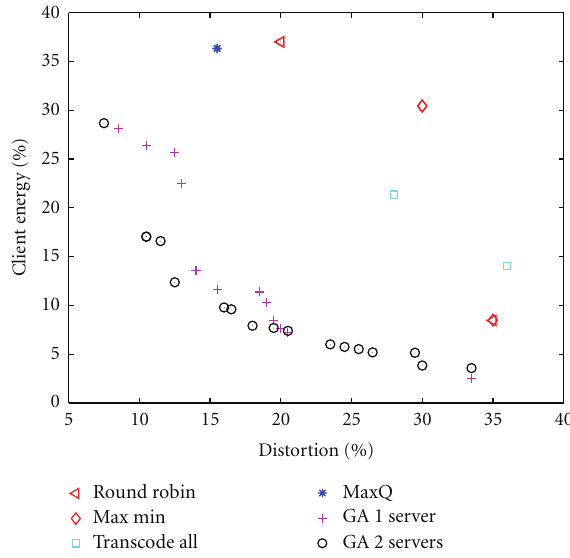
Figure 6: Energy-distortion tradeo ff